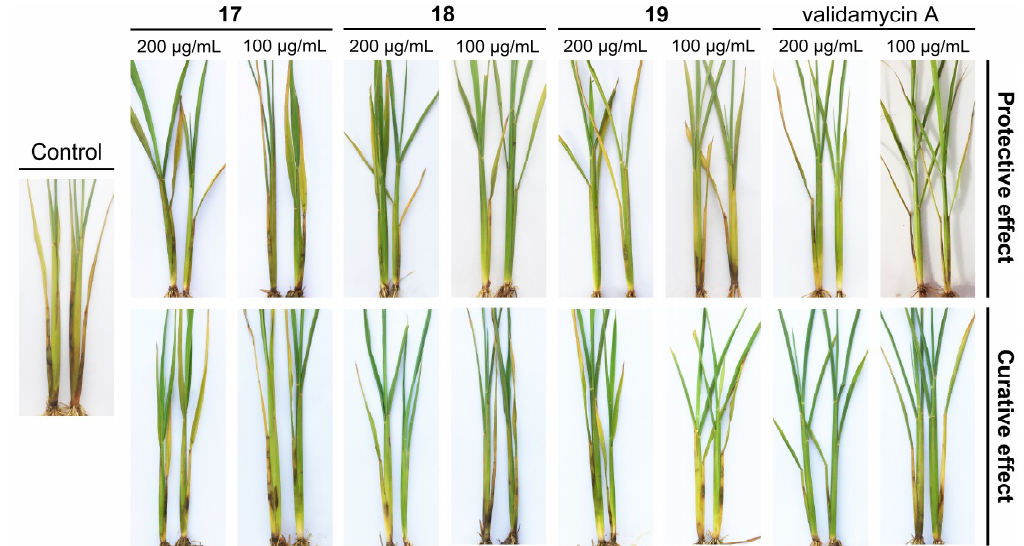
Figure 4. The in vivo protective and curative activities of compounds 17 – 19 against R. solani.